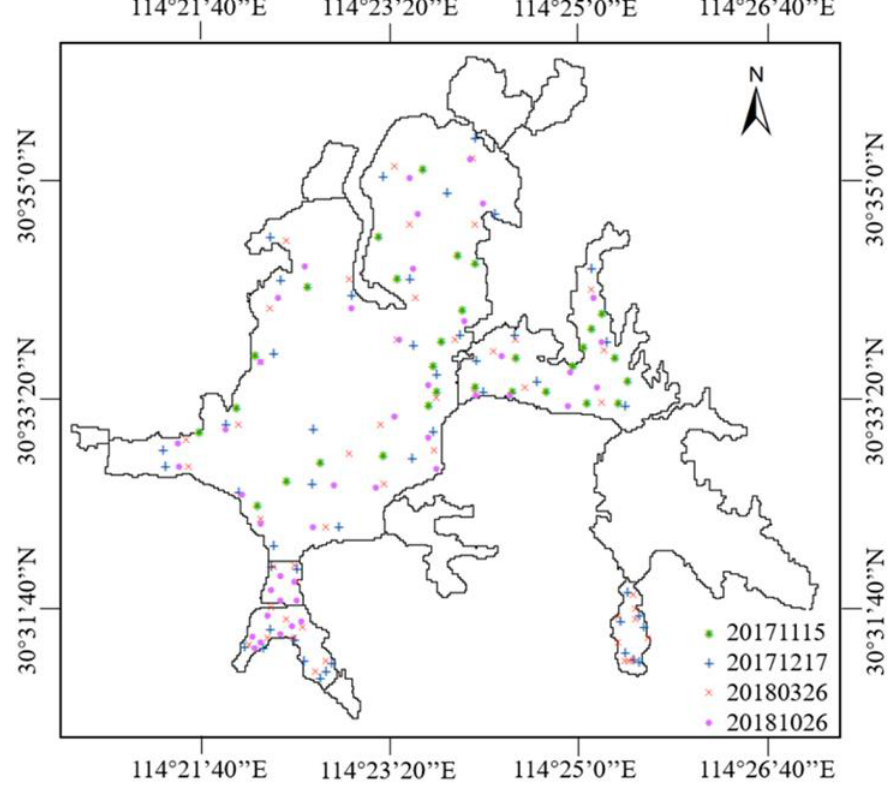
Figure 1. Distribution of sampling points in Donghu Lake.